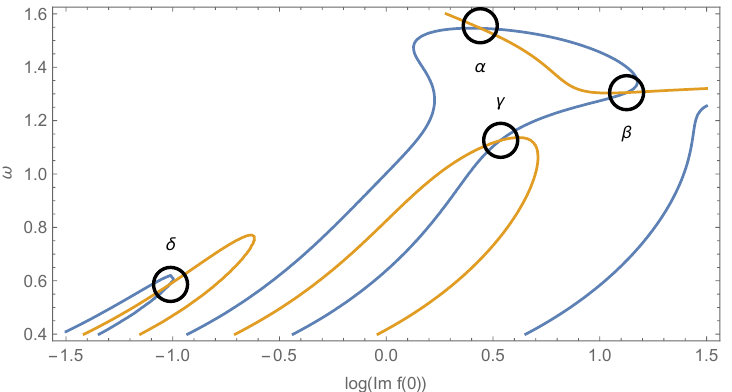
Figure 9 . Plot of absolute value (blue), real and imaginary parts (orange) of G ( !; 1) in the d = 5 parabolic case.